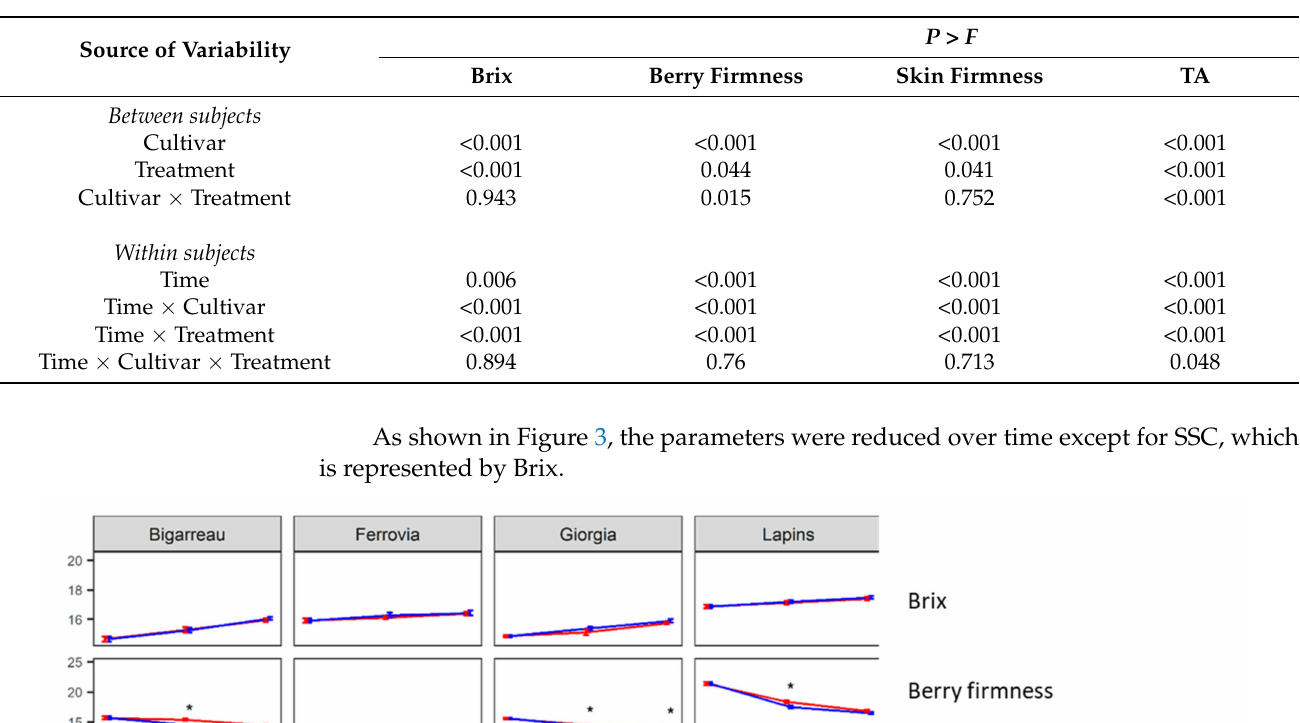
Figure 2. Berry firmness and Brix % of four cherry cultivars, Bigarreau, Giorgia, Ferrovia, and Lapins; berry firmness is expressed as Newton Units and Brix as a percentage. Table 2. Repeated measure (0, 10, and 20 days) analysis of variance for Brix, berry firmness, skin firmness, and TA.